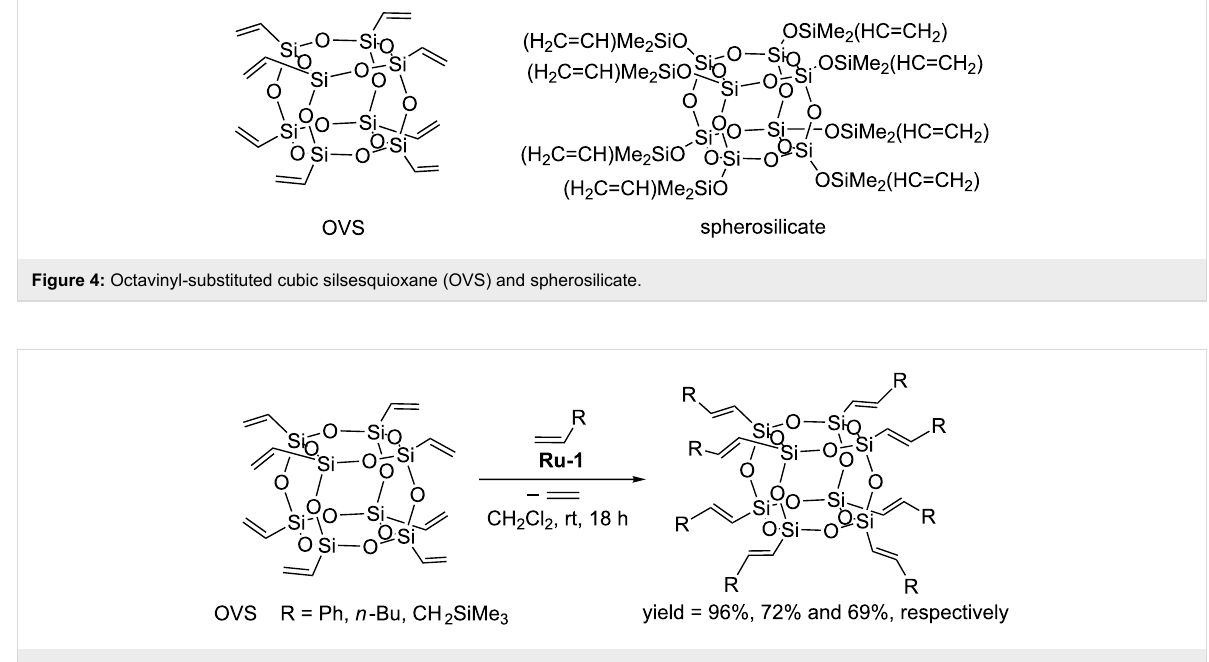
Scheme 3: Cross metathesis of OVS with terminal olefins (stereoselectivity as discussed in the text).